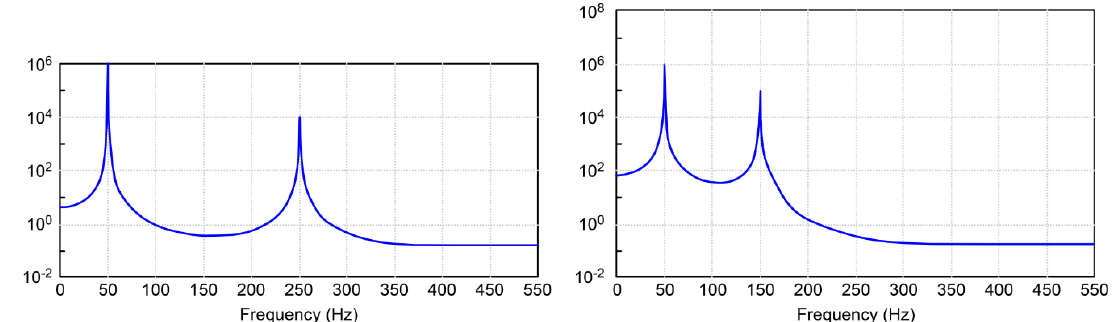
Figure 11. Frequency spectrum determined by music for a motor in good condition and another with voltage imbalance problems, as shown in [49]. Reproduced with permission from IEEE,